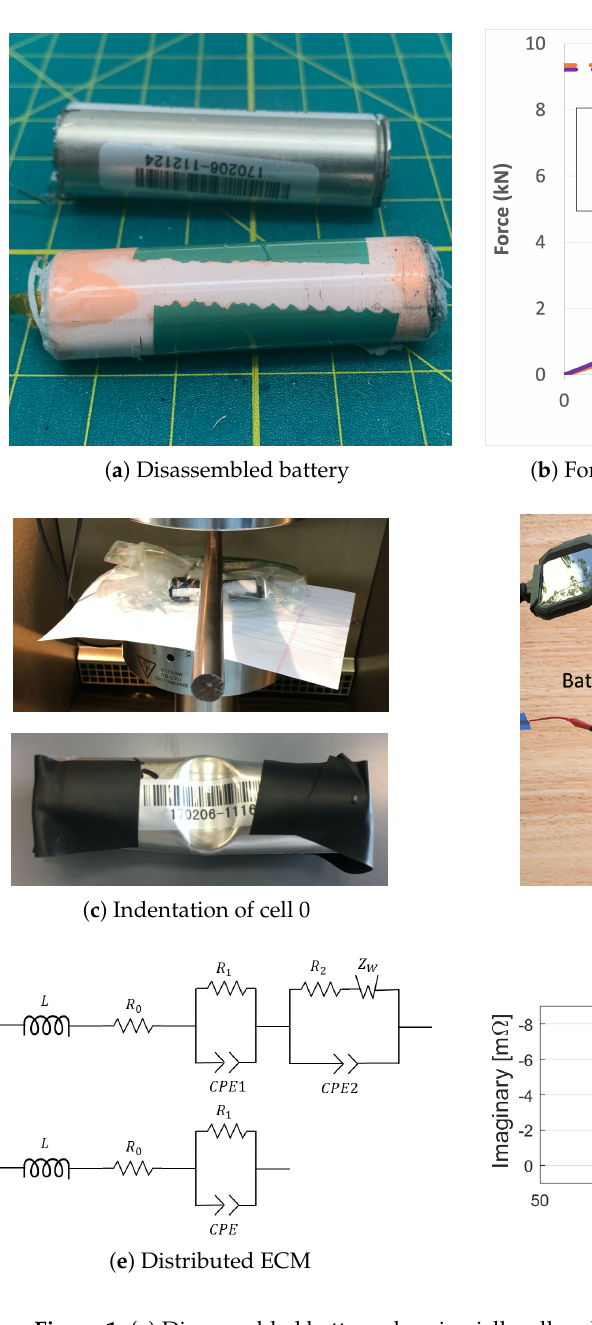
Figure 1. ( a ) Disassembled battery showing jellyroll and casing, ( b ) Force-displacement and voltage of cell 0 and cell E, ( c ) Indentation test of cell 0, ( d ) Experimental Setup shows the Vector Network Analyzer, the battery cell, and a thermal camera, ( e ) The equivalent electrical circuit including an inductor, resistors, and constant phase elements (CPEs) (see text), ( f ) An example of the EIS plot (cell